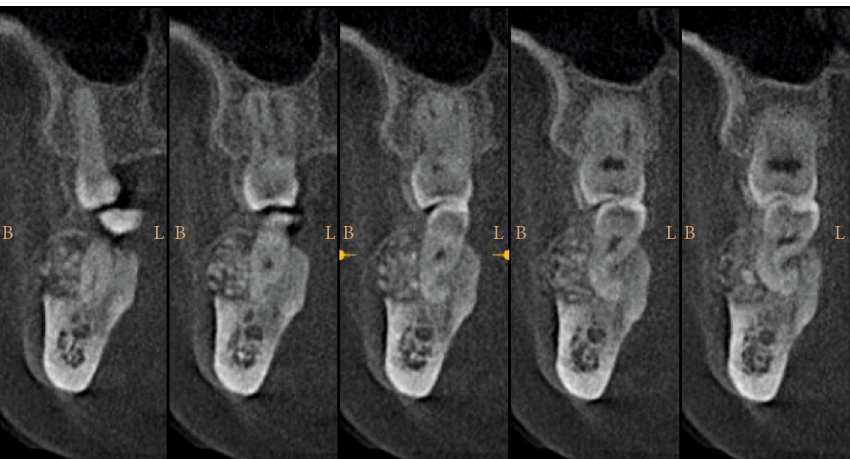
Figure 3: CT coronal cross slides of right posterior mandible showing expansion of the vestibular cortical.